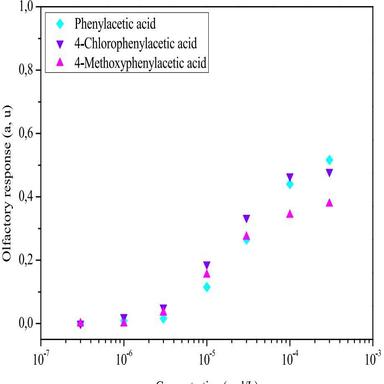
Experimental dose-olfactory response curves of ORA1 activated by phenylacetic acid (ocean symbol), 4-chlorophenylacetic acid (violet symbol), and 4 methoxyphenylacetic acid (magenta symbol).